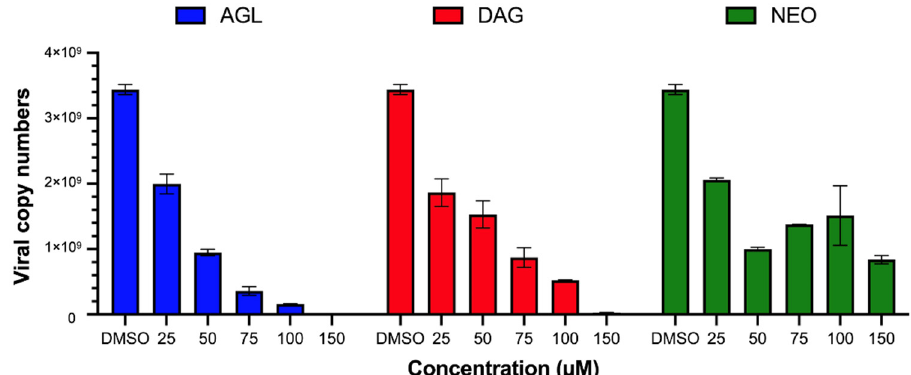
Figure 2. Viral copy numbers in andrographolides treated, FMDV infected BHK-21. Viral nucleic